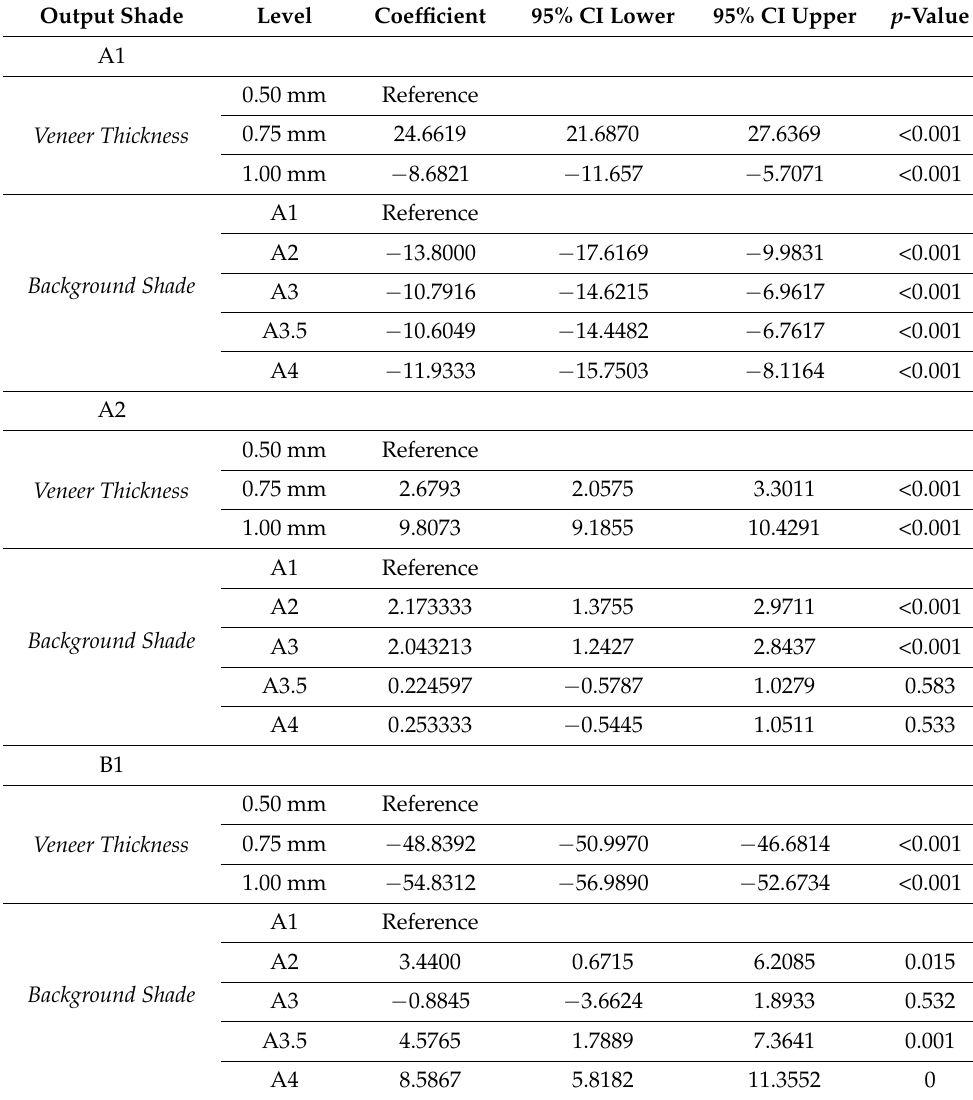
Table 3. Multiple linear regression analysis for percentage of output shades as outcome, considering both the veneer thickness and background shade as